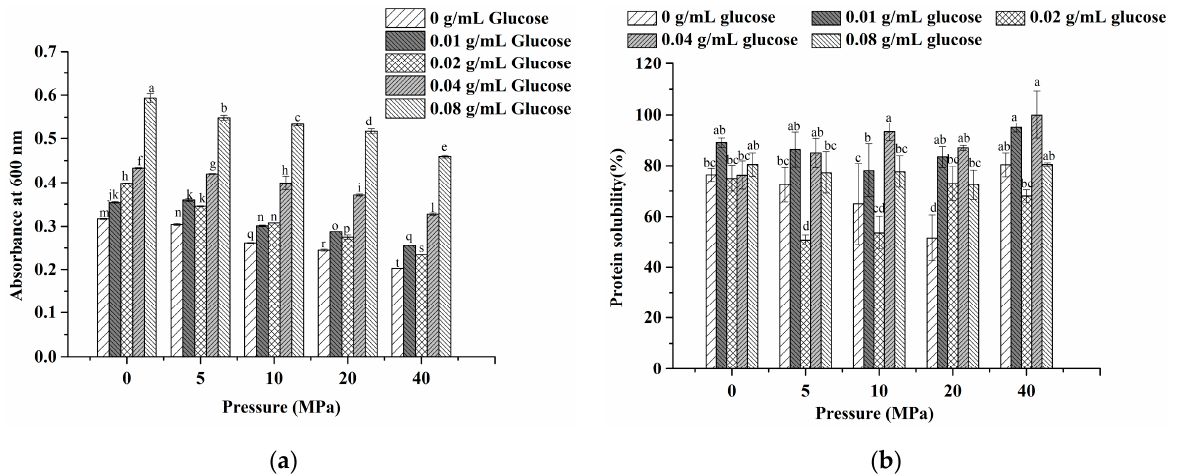
Figure 5. The turbidity ( a ) and solubility ( b ) of LWE under different homogenization pressure treatment and glucose concentrations. Note: The turbidity was defined by absorbance at 600 nm. Significant differences were indicated with different letters ( p < 0.05).